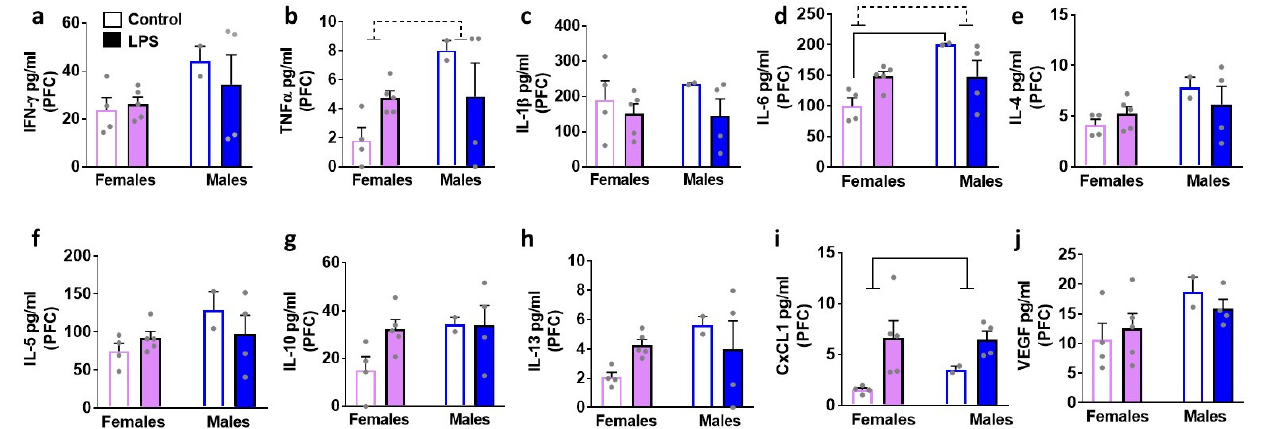
Figure 4. Cytokines, chemokines, and VEGF were measured in the prefrontal cortex (PFC) of female and male rats that were exposed to saline or LPS challenges. Pro-inflammatory cytokines are indicated in panels ( a – d ). Anti-inflammatory cytokines are indicated in panels ( e – h ). Chemokine is indicated in panel ( i ) and angiogenesis marker is indicated in panel ( j ). Data are represented as mean ± S.E.M. n = 4 control female, n = 5 LPS female, n = 2 control male, n = 4 LPS male. Main effect of LPS ( p < 0.05) is indicated by solid line with flat arrowheads, and main effect of sex ( p < 0.05) is indicated by dashed line with flat arrowhead. Differences between saline and LPS within each sex and between sexes ( p < 0.05) are indicated by separate solid lines.